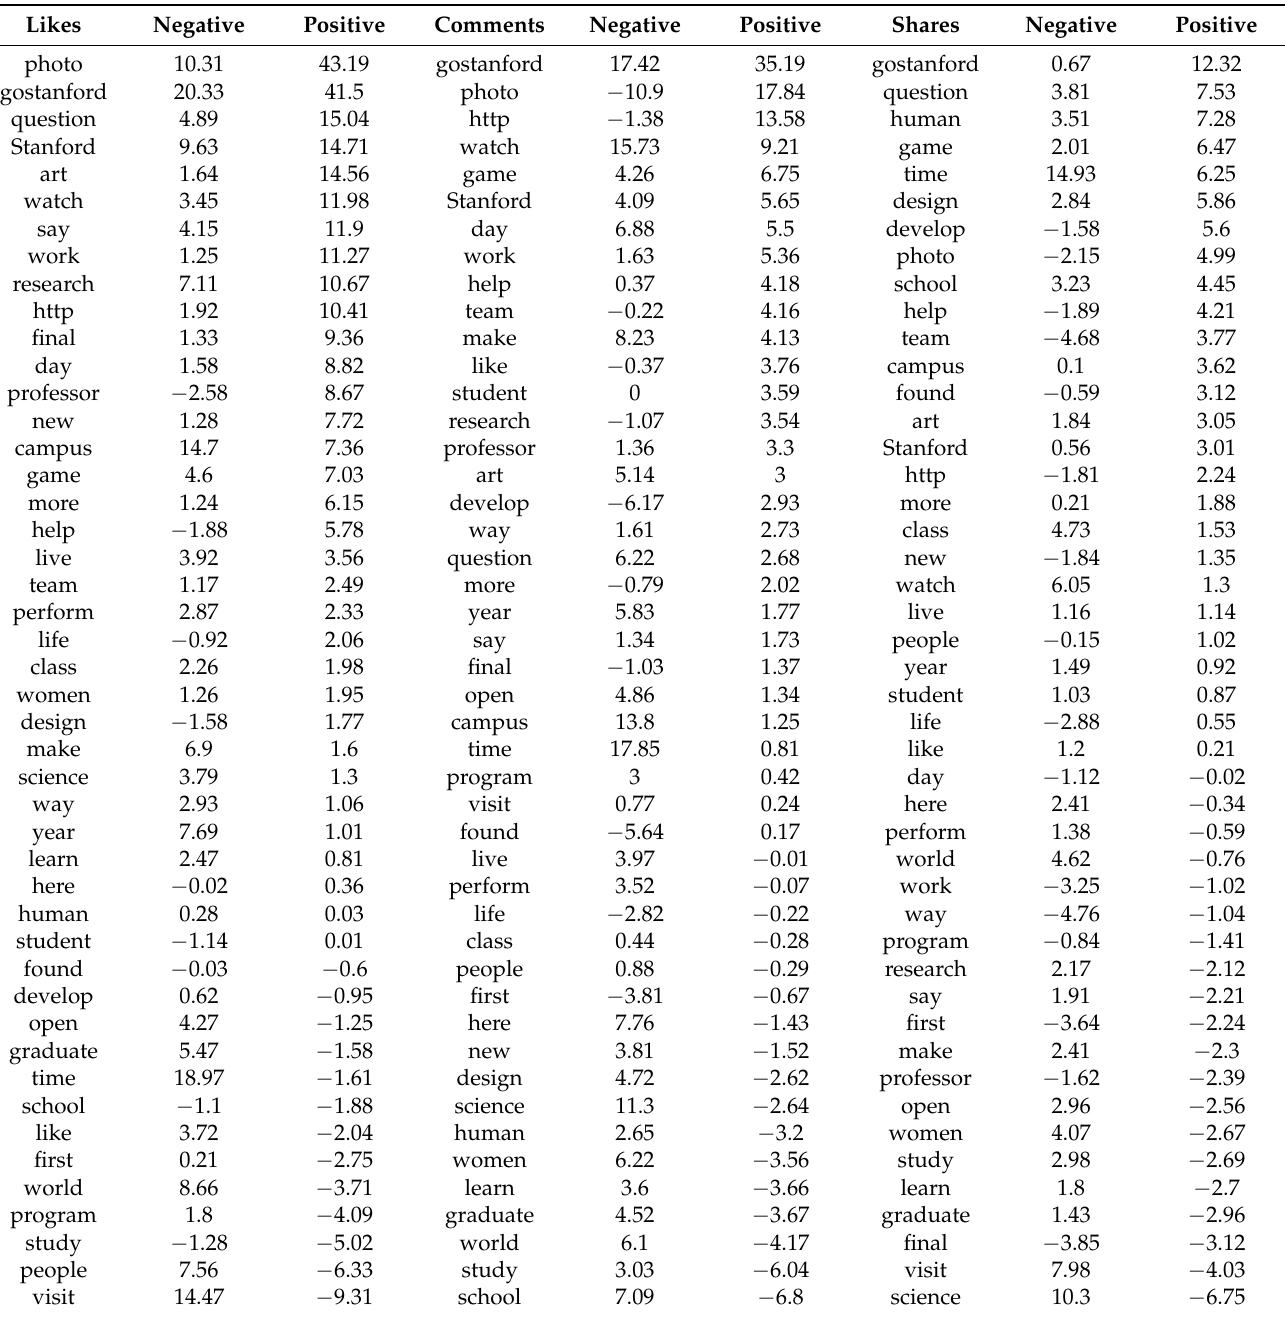
Table A1. Negative and positive clues (Stanford